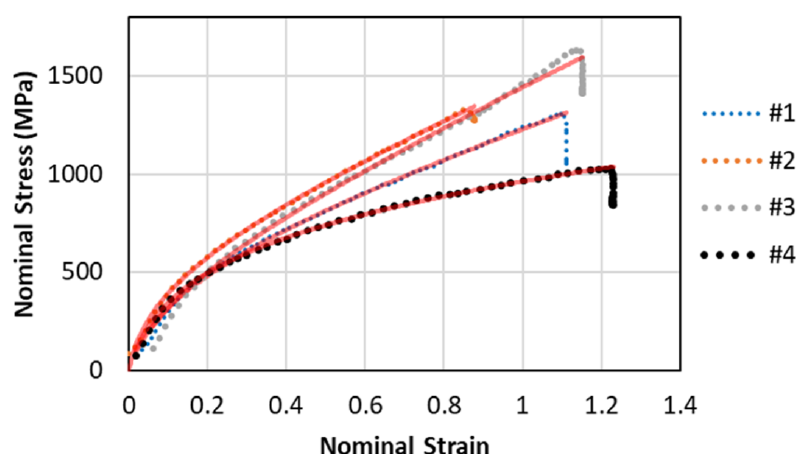
Figure 4. Selected results of raw force-displacement data from compression experiments for Inconel 718 particles of different dimensions (Table 1, particles #1–4) as measured by confocal microscopy.